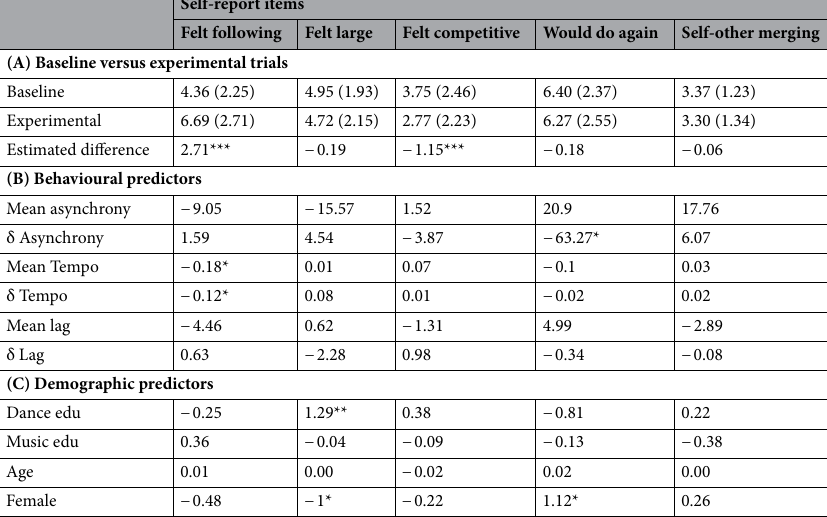
Table 1. Self-report measures across trials and as predicted by other measures. ( A ) Mean (± SD) self-report ratings from Baseline and Experimental trials, and estimated differences between each trial type. ( B , C ) Regression weights for behavioural and demographic predictors of self-report ratings on experimental trials. Weights are estimated by fitting a multiple regression model for each self-report item. *p < .05; **p < .01, ***p < .001, uncorrected